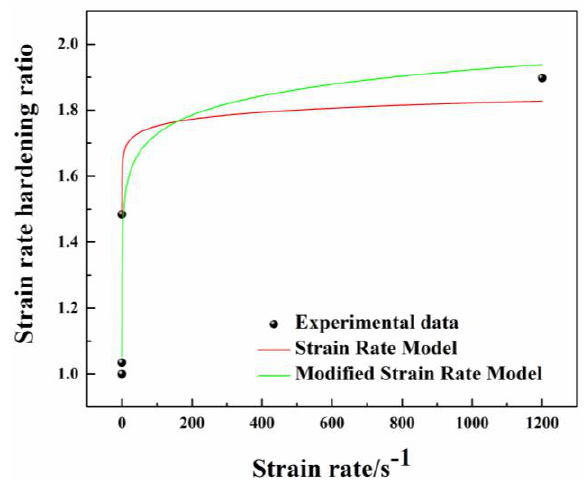
Figure 13. Experimental data and fitting curves of strain rate models. Table 7. Equations of strain rate models.